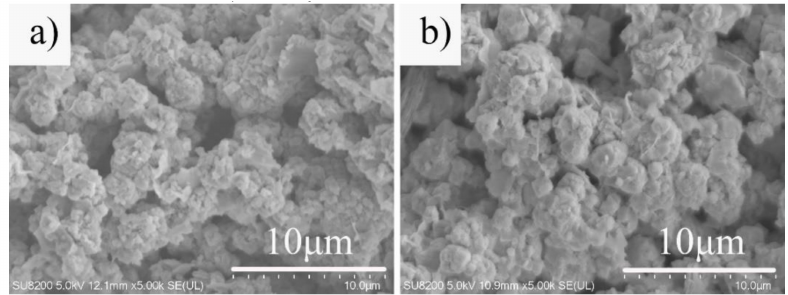
Figure 6. SEM micrographs of the samples A2-T90-H12 ( a ) and A2-T110-H36 ( b